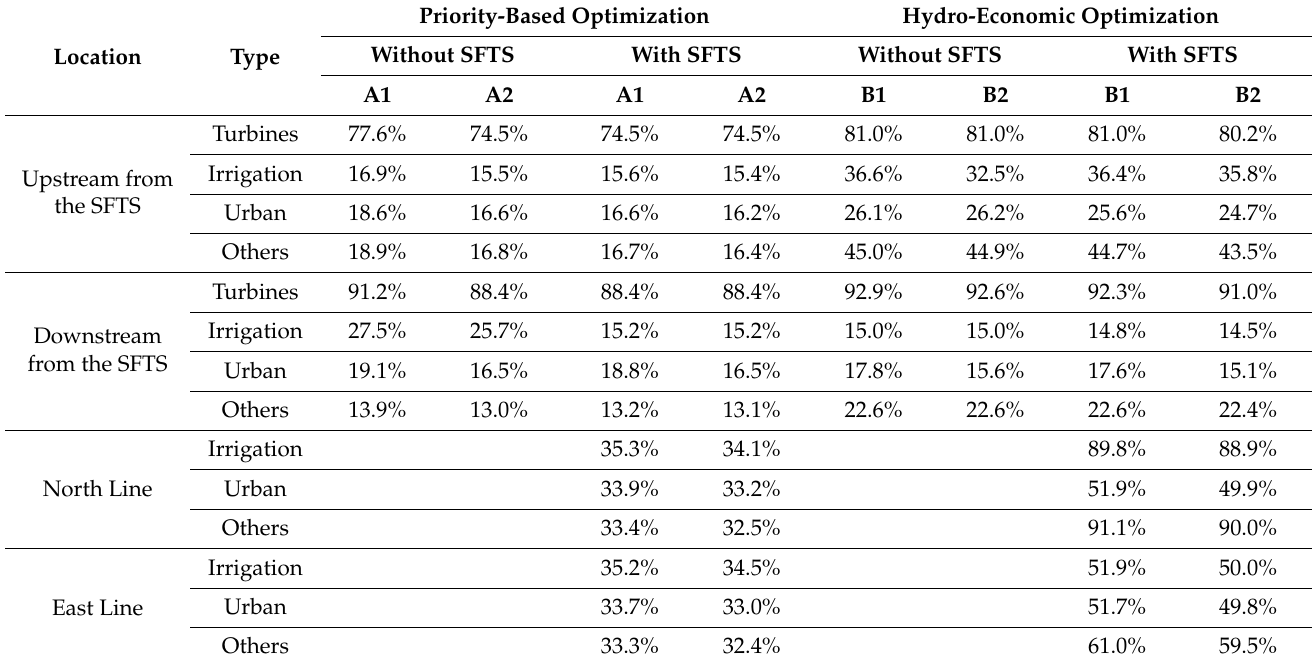
Table 3. Fulfillment of the average flows of the S ã o Francisco River basin and the SFTS, as